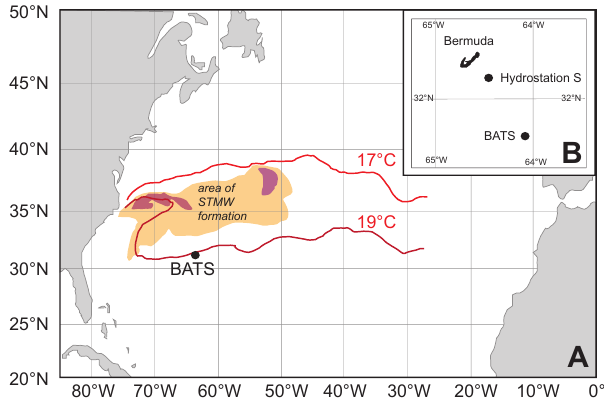
Fig. 1. Location map of general area of STMW outctop and the BATS site near Bermuda in the NW Atlantic Ocean. (A) General outcrop area of STMW in the NW Atlantic Ocean, showing loca- tions of climatological 17 ◦ C and 19 ◦ C isotherms and mean STMW formation rate area (orange and purple) for the 2004–2006 period from Marshall et al. (2009). This figure is modified from Fig. 2a and Fig. 12a of Marshall et al. (2009). (B) Location of the BATS (Bermuda Atlantic Time-series Study; 31 ◦ 40 0 N, 64 ◦ 10 0 W) site as well as the long-term Hydrostation S ocean